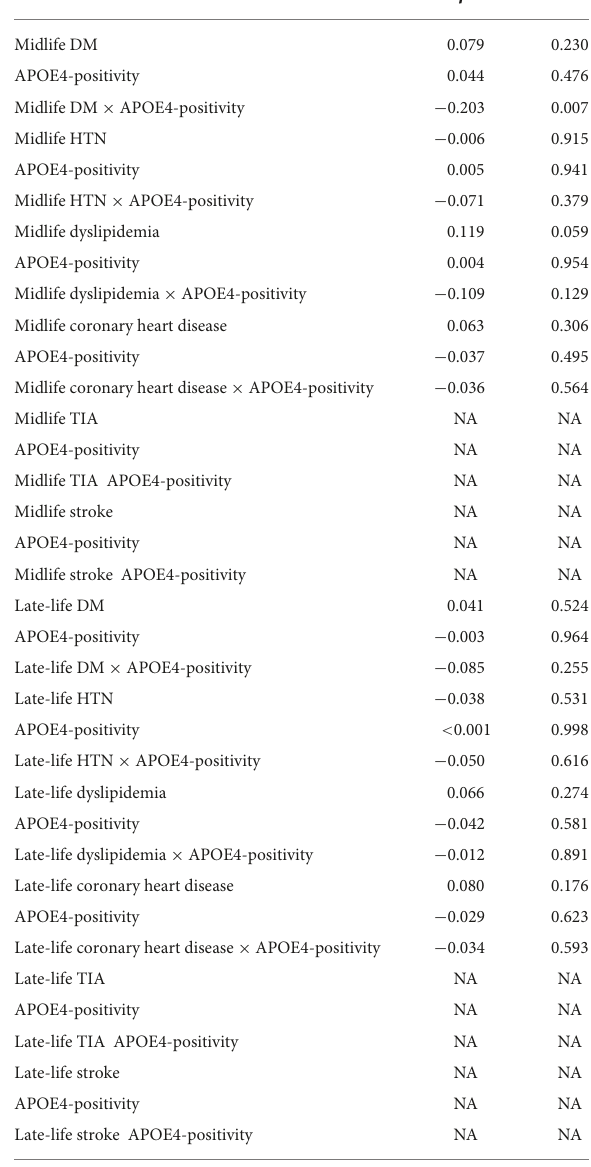
TABLE 1 Demographic and clinical characteristics of the older participants.